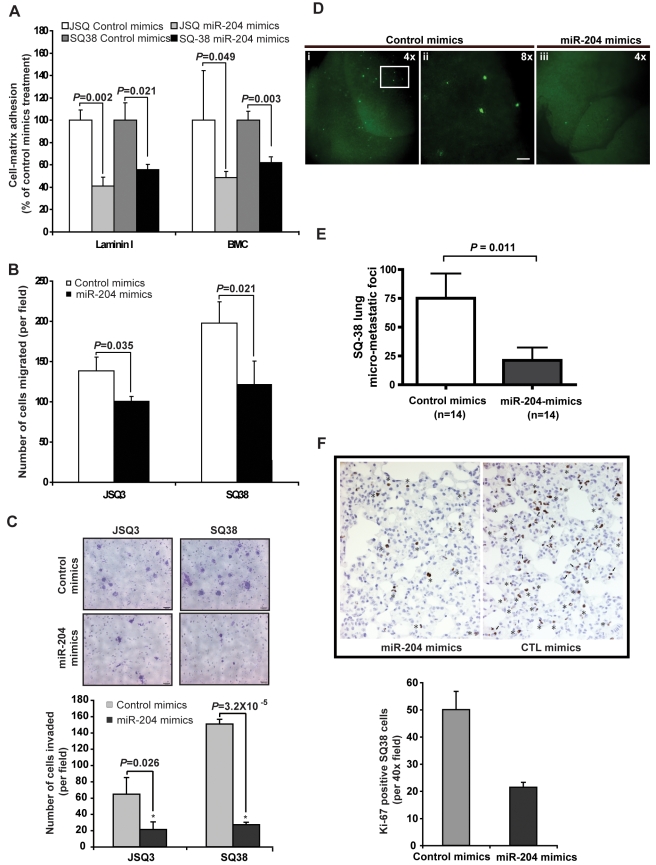
miR-204 suppressed HNSCC cell migration, adhesion and invasion in vitro and lung colonization in vivo.(A–C) Ectopic enhancement of miR-204 function inhibited JSQ3 and SQ38 adhesion to laminaI or basement membrane complex (BMC) (A), migration through the porous membrane in Transwell (B), and invasion through Matrigel (C). Triplicate repeats were conducted at experimental point for A (Methods). For B and C, cells migrated to the basal side of the porous membrane was visualized with a Zeiss Axiovert microscope at ×20 magnification. 10 random fields from three replicate wells were counted and the number of cells that had migrated or invaded was presented as number of cells counted per field of the porous membrane (Materials and Methods). Error bars represent mean±standard error of the mean (SEM); P-values were obtained using a one-tail t-test with unequal variance. (D–E) Restoration of miR-204 function by miR-204 mimics treatment significantly attenuated GFP-SQ38 tumor lung colonization. Total number of GFP-SQ38 lung surface foci was counted lobe by lobe using a Leica fluorescent stereoscope under 4× magnification [D(i) and E(iii)] in a total of 28 mice. A magnified view (8×) of the insert in E(i) is shown in D(ii) (top). Scale bar: 100 µm, Error bars represent mean±SEM. (F) Restoration of miR-204 function significantly decreased Ki-67 positive SQ38 cells in the lung. Ki-67 positive cells in each section were counted in 10 randomly chosen fields (40×) and six specimens in each experimental group were used (left panel). Error bars represent mean ± SEM; In (E) and (F), P-values were calculated based on unpaired one-tailed Mann-Whitney test. The image is a representation of a microscopic field (right panel). * indicates single-cell GFP-SQ38 foci; arrows indicate multi-cell GFP-SQ38 foci.